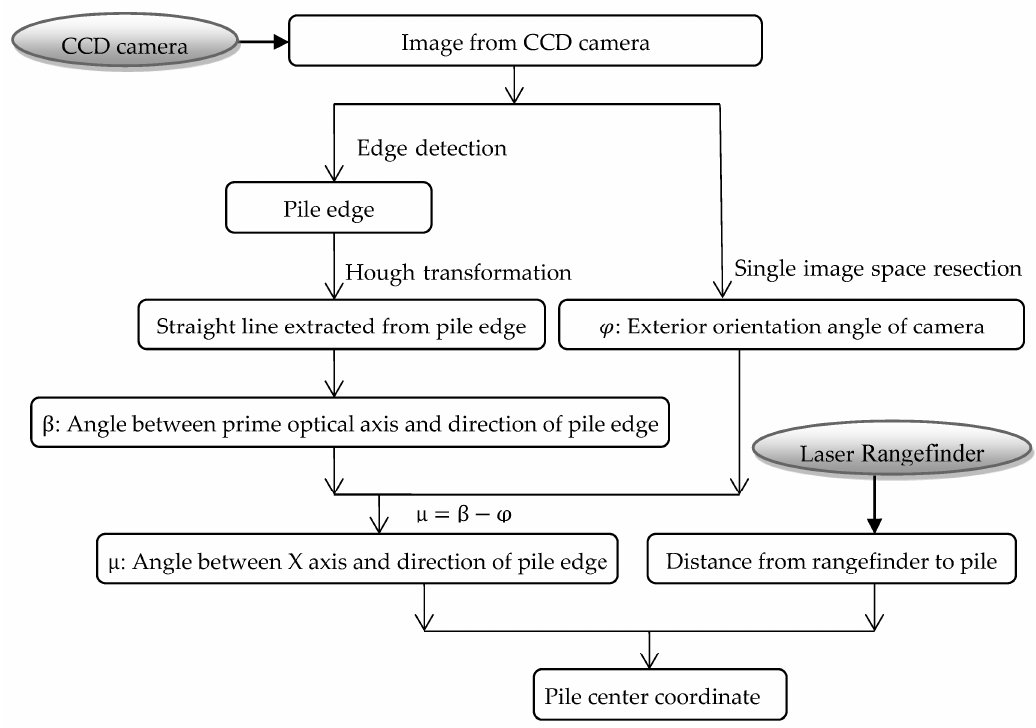
Figure 5. Processing flowchart of the CCD camera and rangefinder data.